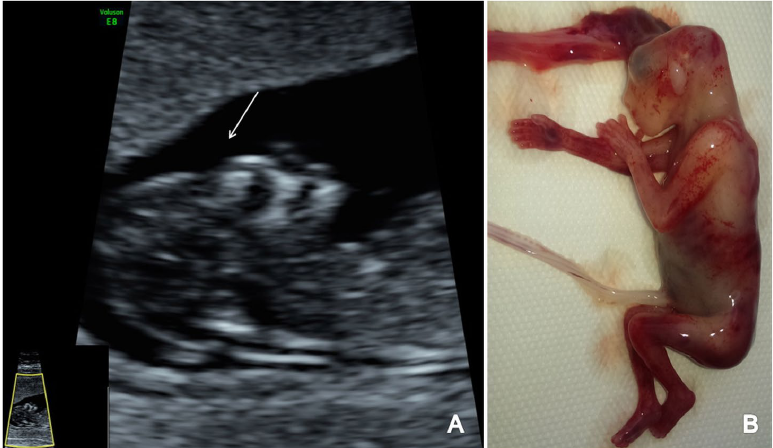
Figure 6. A case of anencephaly diagnosed at 12 weeks + 4 days weeks (Case7): ( A ) sagittal view of the absence of cranial bones ossification (arrow); ( B ) specimen presentation aspect after medical TOP.